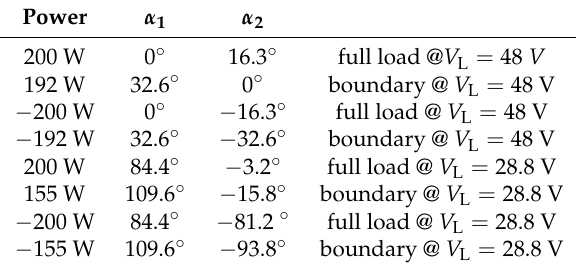
Table 1. Phase-shift angles under PW-DPS control for bidirectional power